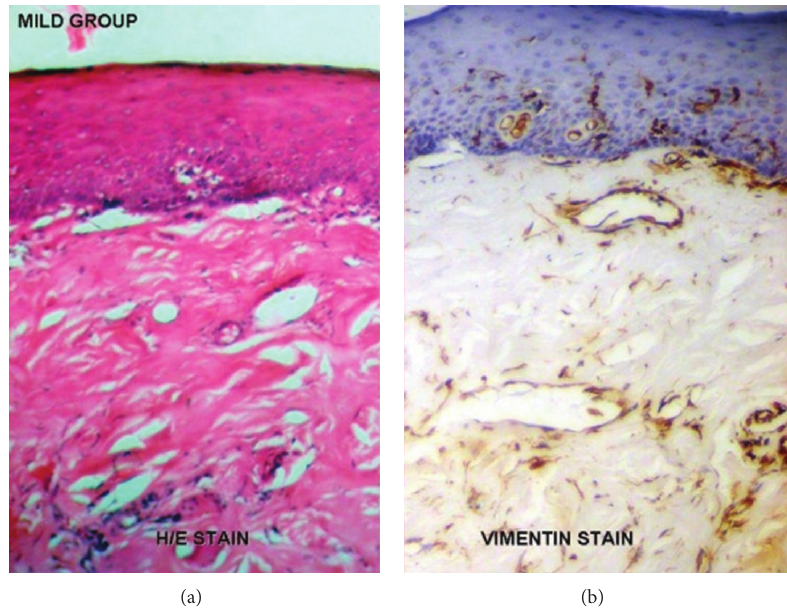
Figure 2: (a) Mild cases of Oral submucous fibrosis under H/E staining. (b) Mild cases of oral submucous fibrosis under vimentin immunohistochemical staining. Note the staining intensity of vimentin in endothelial cells is markedly increased as compared to normal